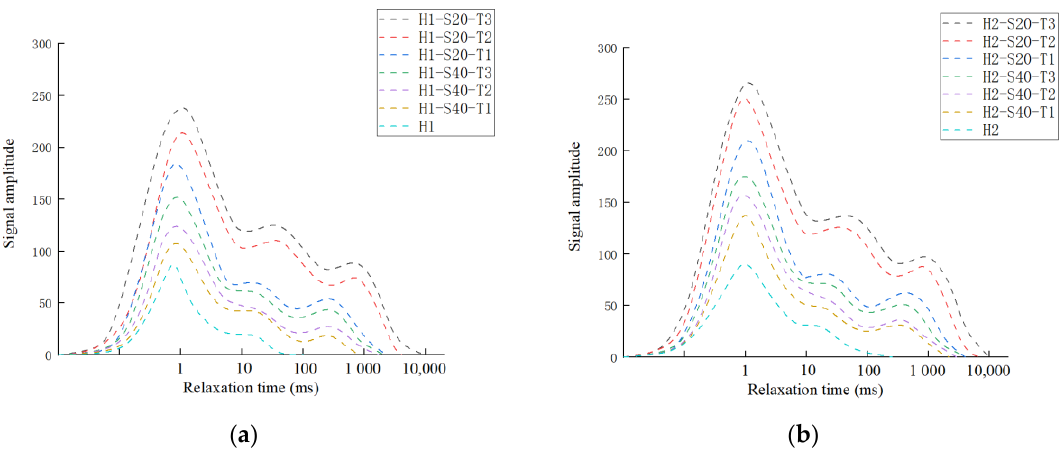
Figure 10. 𝑇 2 spectrum distribution curves; ( a ) H1; ( b ) H2. Figure 10. T 2 spectrum distribution curves; ( a ) H1; ( b )